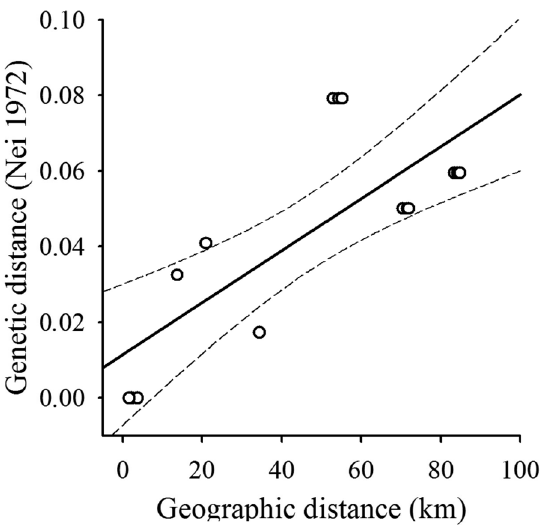
Fig. 3. Genetic distance among E. andevalensis populations as a function of geographic distance: y = 0.0115 + 0.0007 x, r 2 = 0.59, p < 0.01. Dotted lines show 95% confidence limits of re-